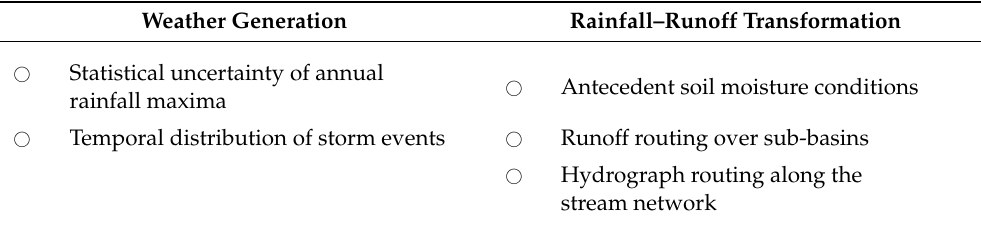
Table 1. Uncertainties for each module considered in the present study. Weather